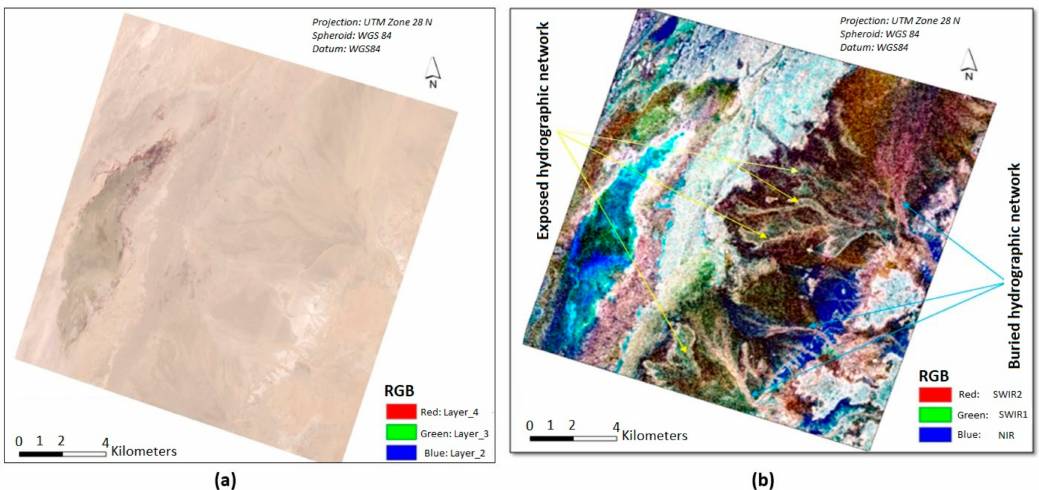
Figure 11. ( a ) RGB color composite of Sentinel-2 MSI, ( b ) the Sentinel-1 SAR merged with the Sentinel-2 MSI image showing the buried hydrographic network (blue) highlighted by the radar data and the superficial hydrographic network (yellow) highlighted by the optic data.